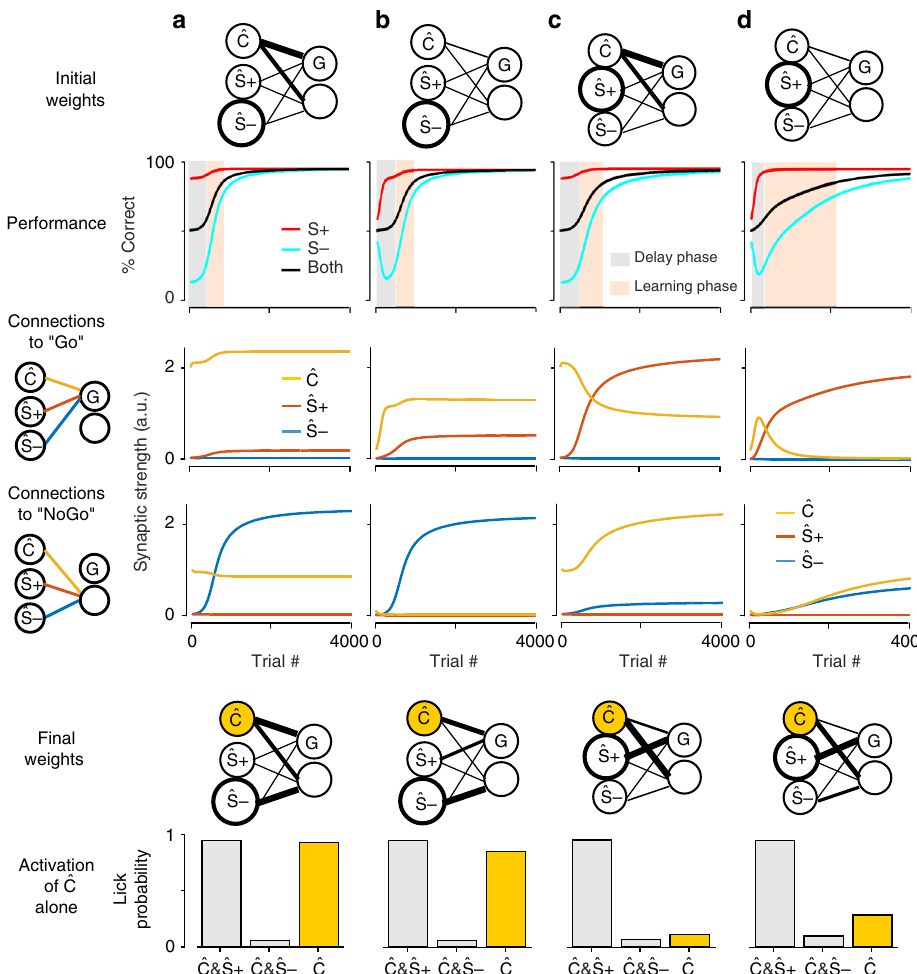
Fig. 5 The effects of neuronal recruitment in the model are explained by the differential adjustment of synaptic weights during learning. a (top) Sketch of the initial synaptic weights and simulated model performance for S + (red), S − (light blue), and both stimuli (black). (middle) Values of the connections to the excitatory (G) and inhibitory decision populations as indicated by the schematics on the left-hand-side. Yellow: connections from the “ common ” Ĉ population. Red: connections from the Ŝ + population. Blue: connections from the Ŝ − population. (bottom) Sketch of the connectivity pattern after and response probability after learning for the S + (co-activation of Ŝ + & Ĉ ) and S − (co-activation of Ŝ − and Ĉ ) reinforced stimuli as well as for the common stimulus component alone ( Ĉ , yellow). Simulation parameters: X = [1; 1; 2], α = 0.01, σ = 0.6195, v = 6, w Ci = 1, w Ce = 2, and w S = 0.01. b . Same as a , but with w Ci = 0.1, w Ce = 0.2. c Same as a , but with X = [1; 2; 1]. d Same as c , but with w Ci = 0.1, w Ce =